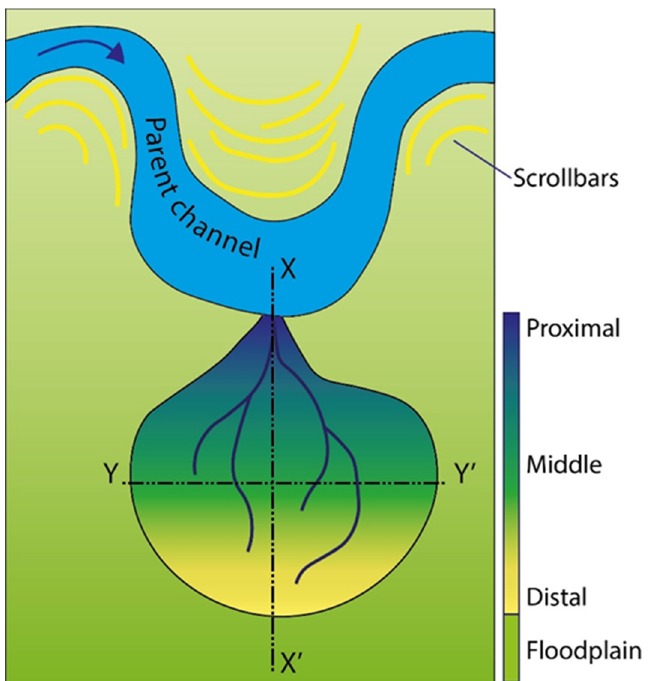
Figure 2. Conceptual sketch of a typica fan-shaped crevasse splays due to a levee break at the external zone of a river belt. The along-dip crevasse sub-division adopted in this work is reported. Direction and terminology for the altimetric profiles elaborated in this work is also shown. Keys: XX’: along-dip direction; YY’ cross direction.